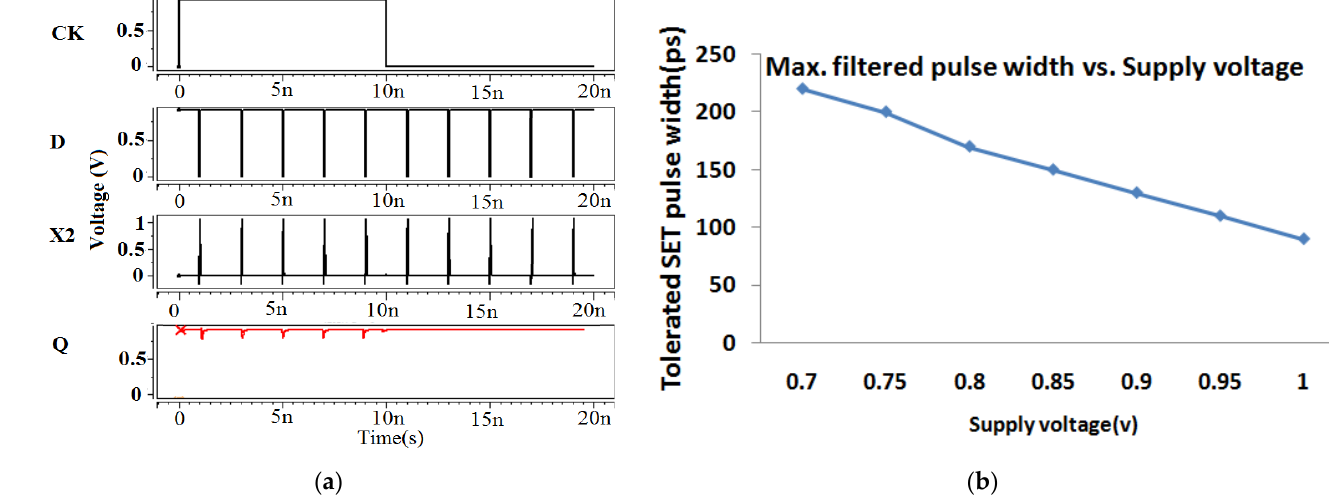
Figure 6. ( a ) SET pulse filtering capability of the proposed D-latch; ( b ) maximum pulse width of SET filtered by the proposed D-latch at various supply voltages.